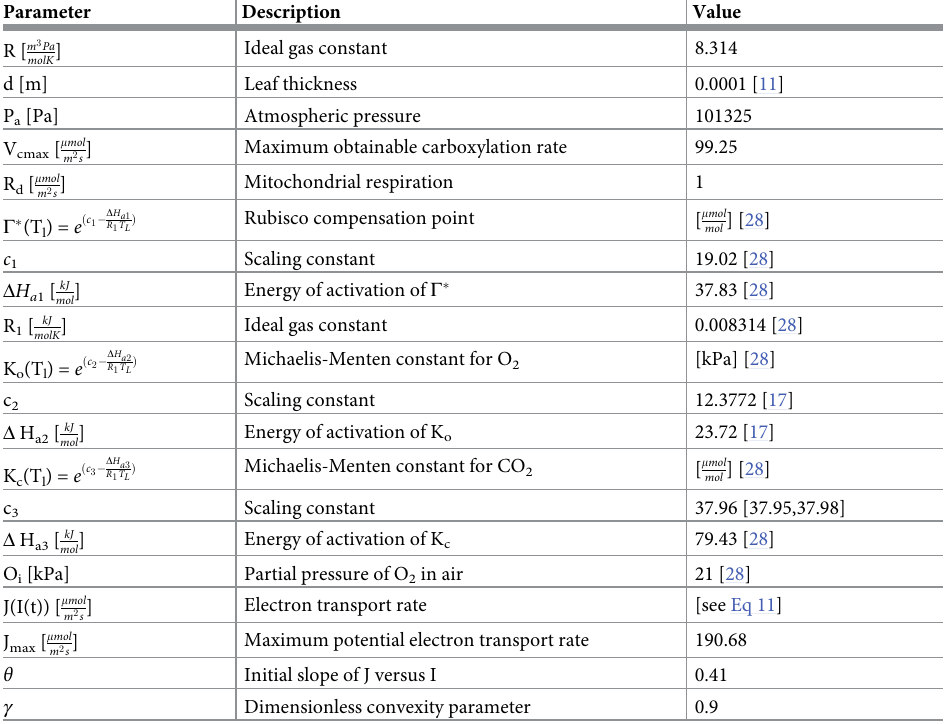
Table 3. Values of the model parameters in expression 18. A priori estimated parameters of function J(I(t)) and the respective steady-state parameters V cmax and R d are given. The unknown system parameter and its confidence interval is also shown. Finally, the parameters related to the temperature dependence of key FvCB model parameters are also